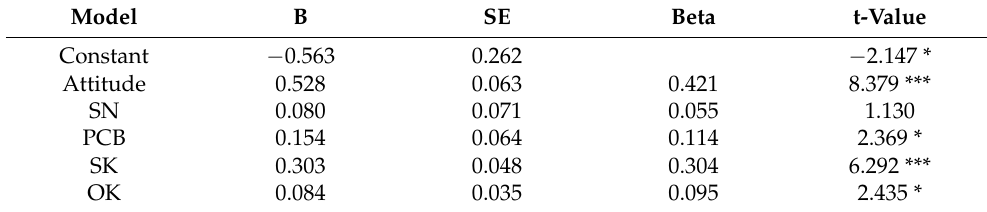
Table 4. Results or regression